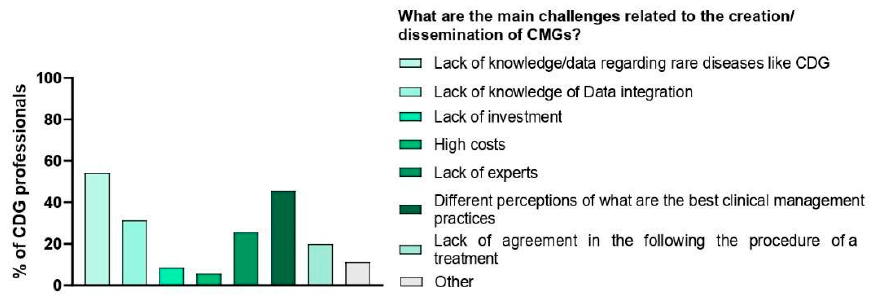
Figure 6. Main challenges related to the creation/dissemination of CMGs.